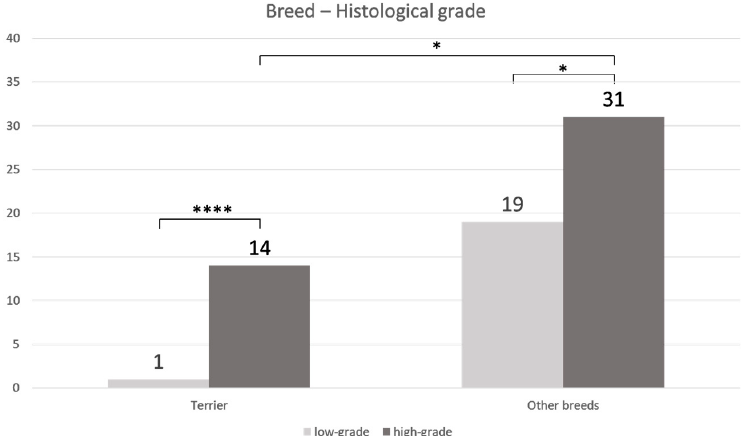
Figure 2. Correlation between histological grade and breed: A significantly higher percentage of high-grade transitional cell carcinoma (TCC) compared to low-grade TCC was observed in terriers (**** p < 0.0001) and in non-terriers (* p ≤ 0.05). Furthermore, a considerably higher percentage of high-grade transitional cell carcinoma was observed in terriers compared to non-terriers (* p ≤ 0.05) (Fisher’s exact test).